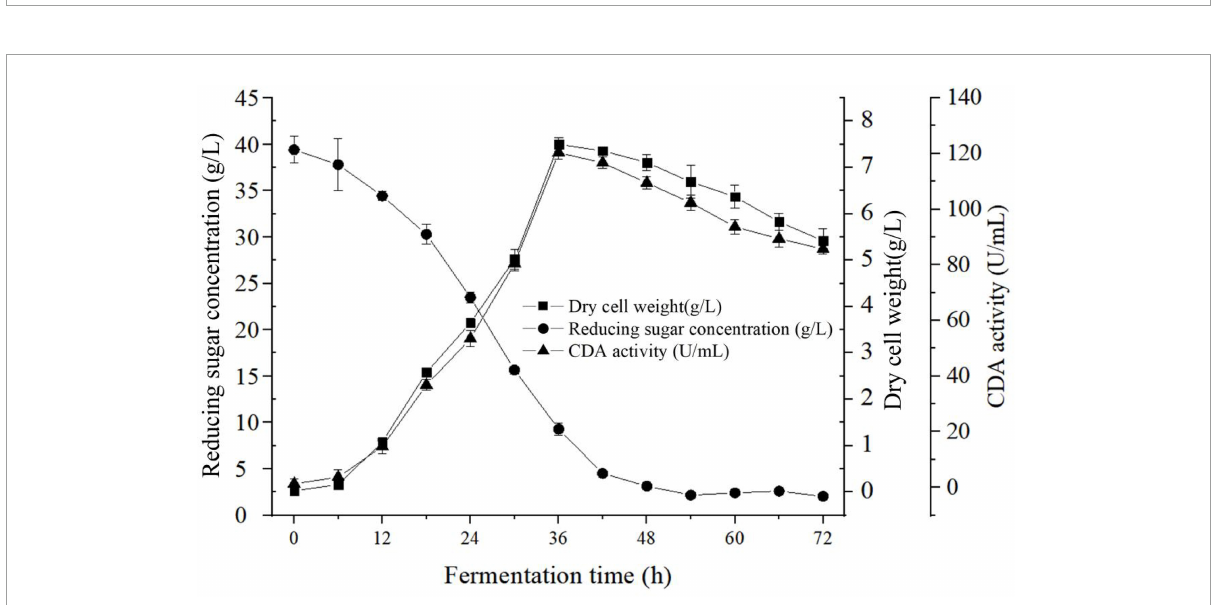
FIGURE3 Fermentation characteristics curve of Bacillus aryabhattai TCI-16.